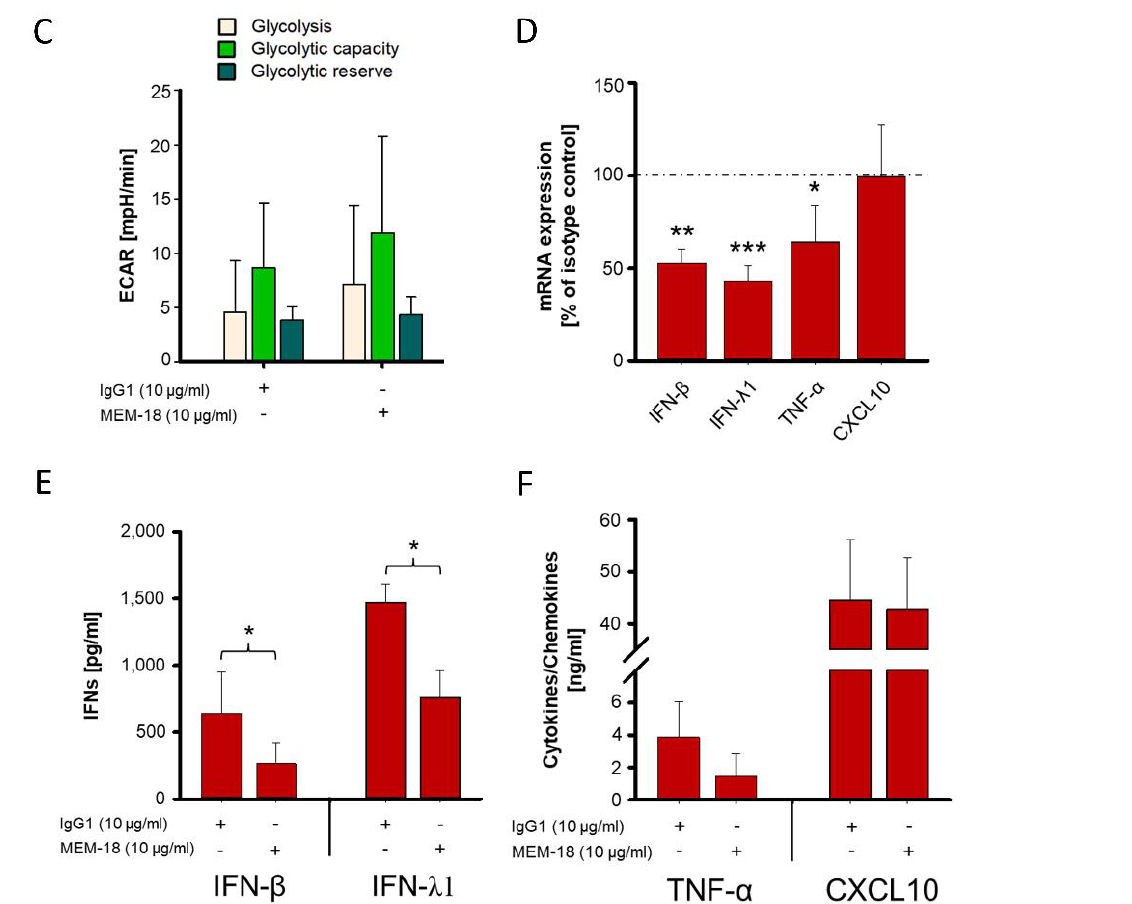
Figure 4. The application of blocking antibodies prior to RuV infection of M-M Φ reveals CD14- dependent and -independent mechanisms of the associated inflammatory response. Anti-CD14 block- ing or corresponding isotype control antibodies were applied to M-M Φ (5 × 10 5 /mL) 30 min before control infection or infection with RuV. ( A ) Western blot analysis of protein lysates (30 µ g/lane) with anti-CD14, anti-E1 and anti- β -actin antibodies at 24 hpi. ( AI ) One representative Western blot from independent experiments of four donors is shown. ( AII ) Western blot results were subjected to den- sitometric analysis for quantification of expression changes ( n = 4). Statistical analysis was performed using ANOVA test and significance was calculated to the respective isotype control ( B ) Extracellular virus particles were determined at 24 hpi by plaque assay. Percent values of the means ± SD are shown ( n = 3) and expressed as percent change compared to isotype control. ( C ) M-M Φ s were subjected to extracellular flux analysis with the glycolysis stress test 24 h after addition of the blocking and control antibodies. Glycolysis and glycolytic capacity/reserve were measured through successive injection of glucose and oligomycin, respectively. Data are shown in bars as the mean plus standard deviation ( ± SD) and were derived from three independent experiments with two wells per sample and experiment. ( D ) The mRNA expression of the indicated cytokines/chemokines in RuV-infected M Φ s was determined at 24 hpi by quantitative real-time PCR. Data normalization was carried out with GNB2L1. Relative mRNA quantification based on 2 − ∆∆ Ct was employed. Expression of indi- cated target mRNA was determined relative to isotype control (isotype control = 100%) ± SD ( n = 3). Statistical analysis was performed using ANOVA test and significance was calculated to the isotype control. ( E , F ) The protein concentrations of the indicated cytokines/chemokines in supernatants of RuV-infected M Φ s were determined at 24 hpi by LEGENDPLEX human interferon panel kit (IFN- β , IFN- λ 1 and TNF- α ) or ELISA (CXCL10). Data are shown in bars as the mean plus standard deviation ( ± SD) ( n = 3). Statistical analysis was performed using ANOVA test and significance was calculated to the respective isotype control. * p ≤ 0.05, ** p ≤ 0.01, *** p ≤